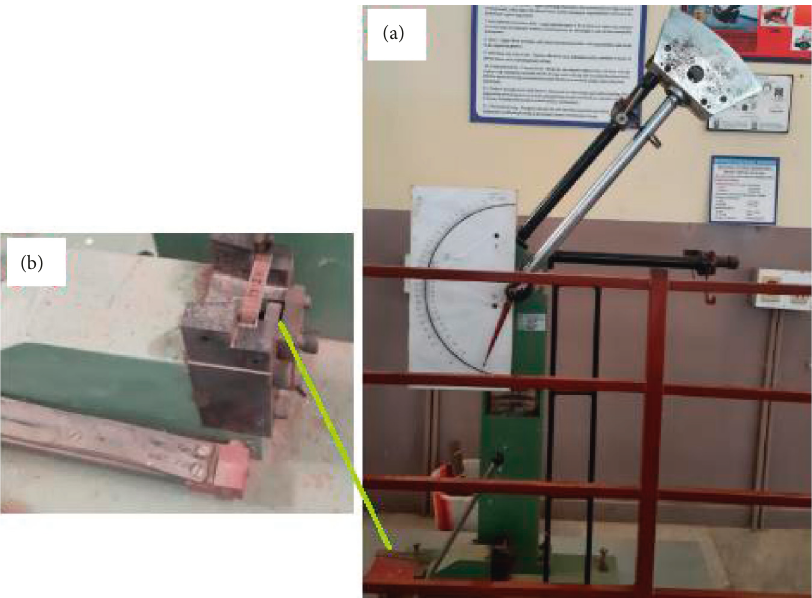
Figure 6: (a) Impact testing machine. (b) Izod test